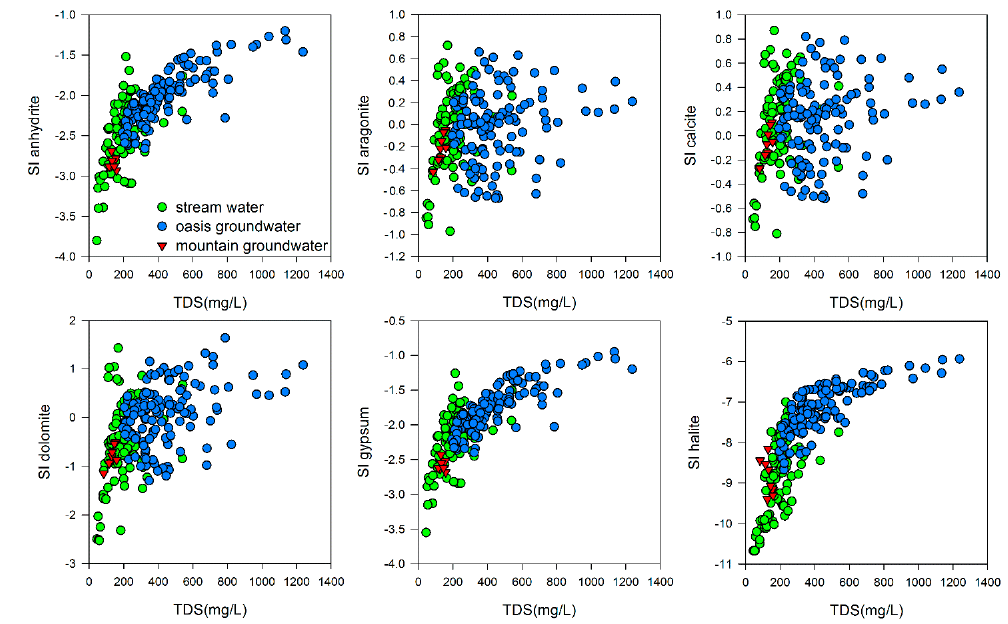
Figure 7. Saturation indices (SI) of some minerals versus TDS (mg / L) in stream water and groundwater.